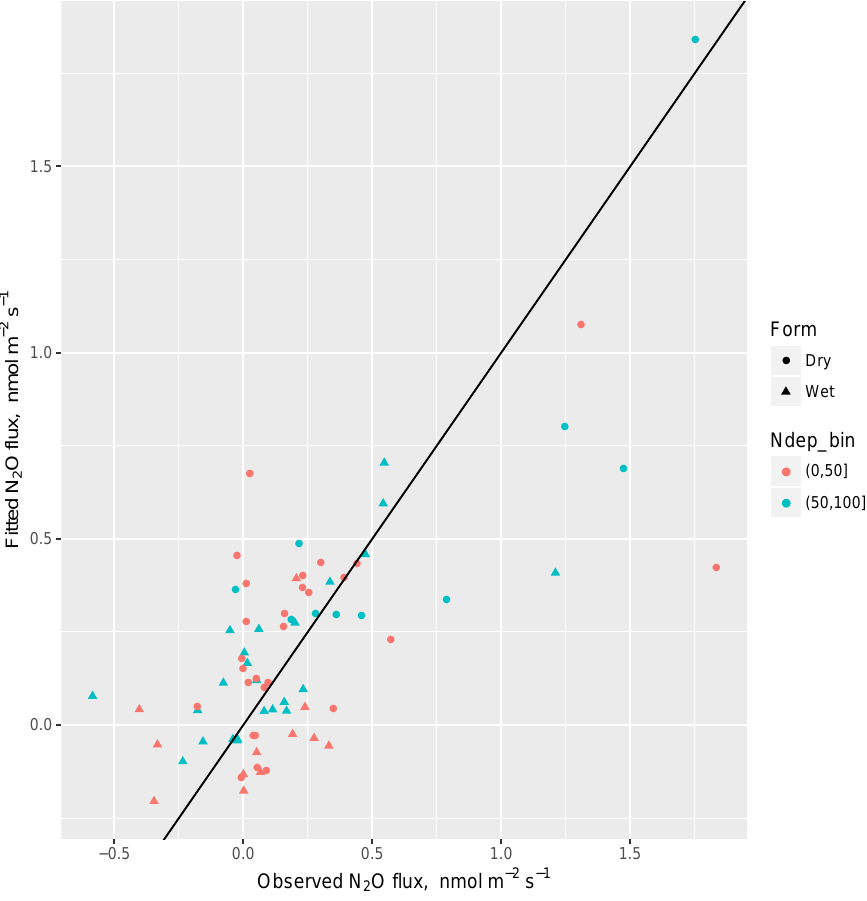
Figure 6. Mean N 2 O flux at each chamber location fitted by the PLS model based on vegetation species composition plotted against observed mean fluxes. The data are grouped by nitrogen treatment form (symbol shape) and dose (symbol colour). The solid line shows the 1:1